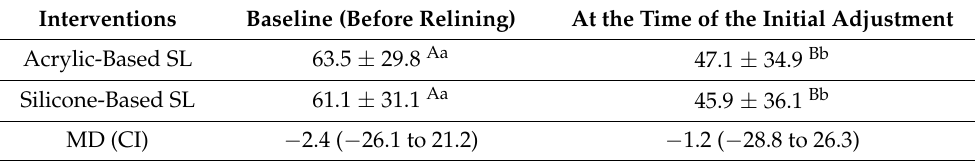
Table 3. Pain perception (Mean ± SD) rating on the 100-mm VAS. Interventions Baseline (Before Relining) At the Time of the Initial Adjustment Acrylic-Based SL 63.5 ± 29.8 Aa 47.1 ± 34.9 Bb Silicone-Based SL 61.1 ± 31.1 Aa 45.9 ± 36.1 Bb MD (CI) − 2.4 ( − 26.1 to 21.2) − 1.2 ( − 28.8 to 26.3) A, B; significant statistical differences can be found in values with dissimilar capital letters in columns (between groups). a, b; significant statistical differences exist between values with dissimilar small letters in rows (between